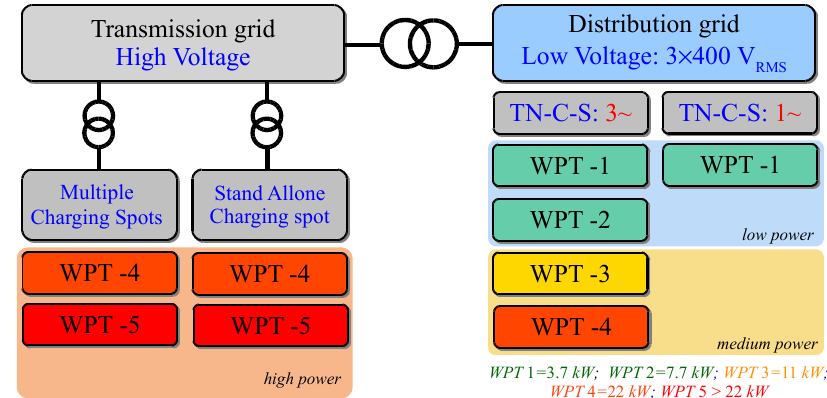
Figure 9. WPT system categories—connection to the grid.